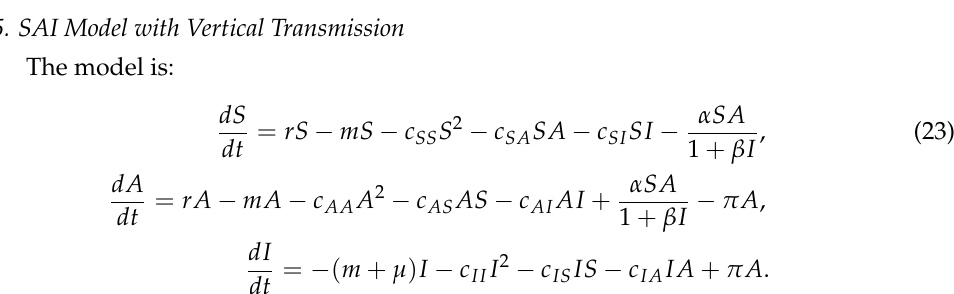
sufficient: (20) numerical